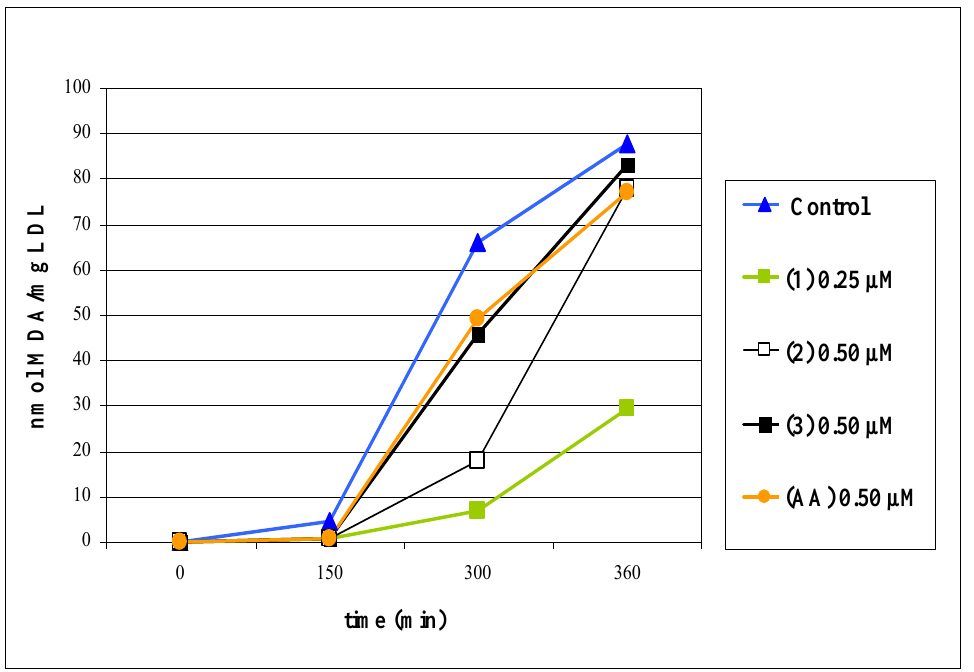
Figure 2. Effects of isoorientin ( 1 ), swertiajaponin ( 2 ) and isoorientin 2"- O -rhamnoside ( 3 ) on MDA formation (nmol of MDA-TBARS/LDL protein) during copper-induced LDL oxidation. AA : Ascorbic acid. The graphic is representative of six separate